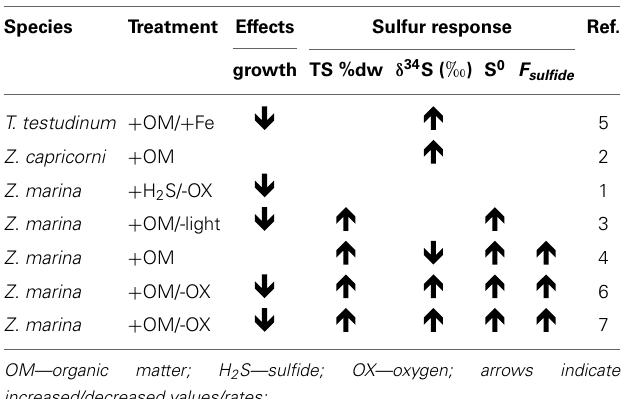
Table 3 | Collection of experimental seagrass studies where sulfide levels were manipulated and sulfur response parameters in the plants were assessed.